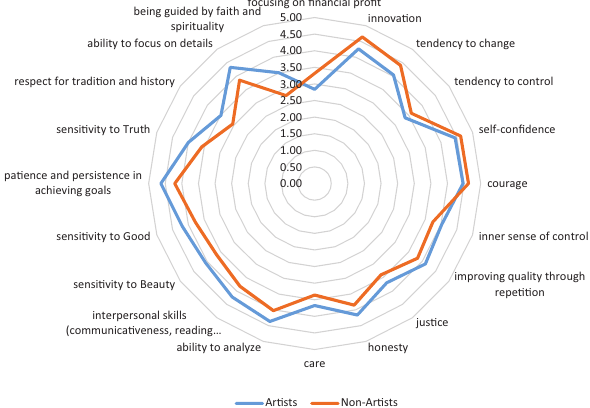
Figure 4. Perception of the most differently assessed features of a creator’s identity by artistic versus non-artistic individuals (source: created by